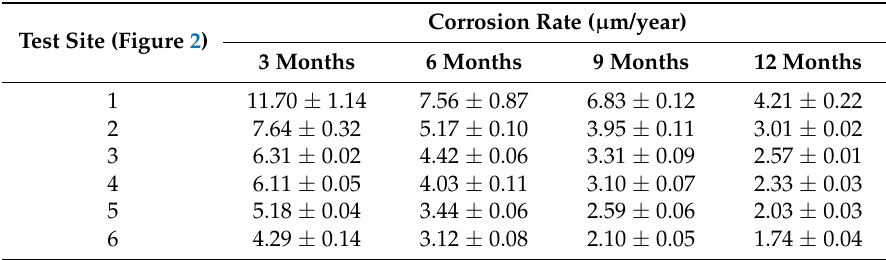
Table 3. Variation in the copper corrosion rate at each testing station after the different exposure times. Average values considering both sides of the